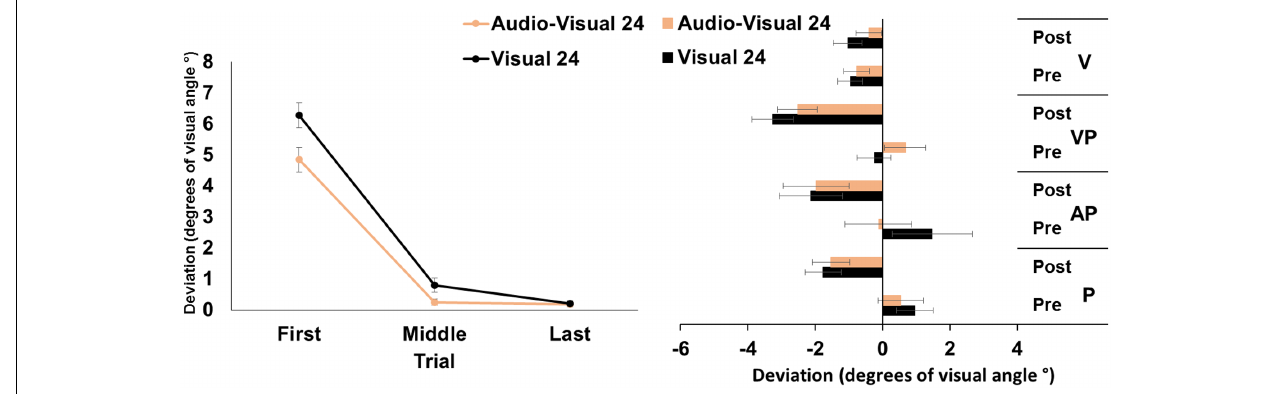
FIGURE 2 | Results from Experiment 2. (Left) Mean (SE) deviation of the pointing movements (average of first, middle, and last four pointings) of the right index finger from the target in the 24-pointings adaptation task in the visual (black), and audio-visual (orange) conditions, in degrees of visual angle ( ◦ ); positive values correspond to rightward deviations from the targets, negative values to leftward deviations. (Right) Mean (SE) deviation from the body midline in the proprioceptive (P), auditory-proprioceptive (AP), visual-proprioceptive (VP), and visual (V) straight-ahead tests, before (pre), and after (post), the visual (black), and audio-visual (orange) conditions of adaptation, in degrees of visual angle ( ◦ ); positive values correspond to rightward deviations from the perceived body midline, negative values to leftward